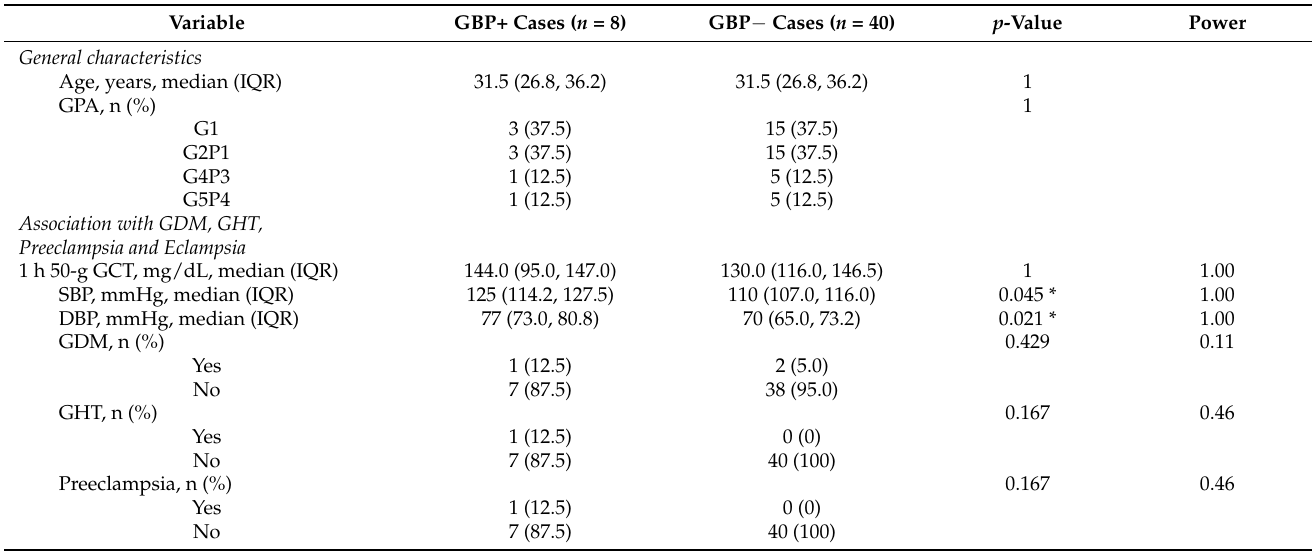
Abbreviations: GPA; gravida/para/abortus (GPA) system, 1 h 50-g GCT; one-hour, 50-g glucose challenge test, SBP; systolic blood pressure, DBP; diastolic blood pressure, mmHg; millimeters of mercury, GDM; gestational diabetes mellitus, GHT; gestational hypertension, SD; standard deviation, IQR; interquartile range. * p < 0.05, Wilcoxon rank-sum